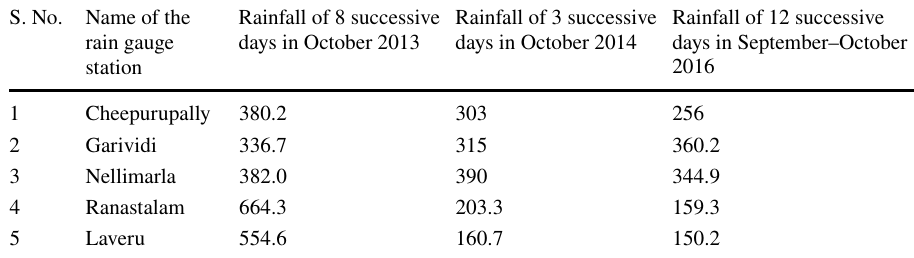
Table 3 Heavy rainfall in ‘mm’ with prolonged time in the years 2013, 2014 and